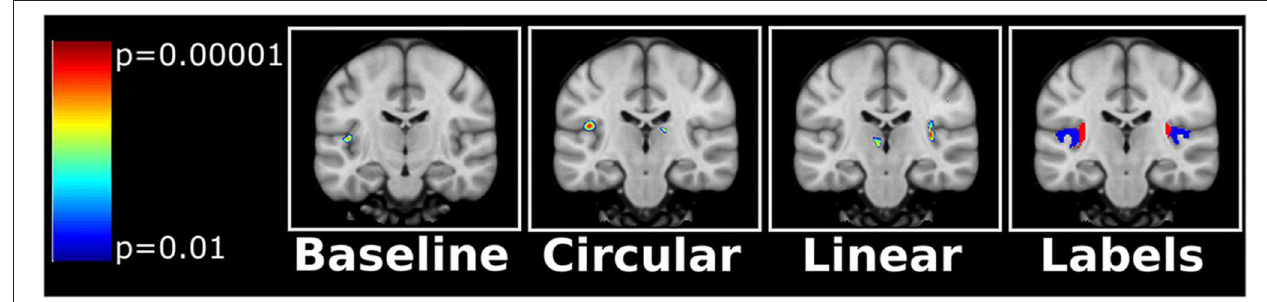
FIGURE 2 | Uncorrected t-maps from the SPM analyses. Decreased 18 F-FDG uptake was evident in Heschl’s gyrus in the patients with Menière’s disease compared to the healthy control group. During linear vestibular stimulation the Menière’s patient displayed a decreased 18 F-FDG uptake in the right Heschl’s gyrus and a cluster in the left thalamus. However, during angular stimulation (circular) the Menière’s patient displayed a decreased 18 F-FDG uptake in the left Heschl’s gyrus/intersection to the parietal operculum. The anatomical regions as defined in the SPM atlas are shown on the right (blue label = Heschl’s gyrus, red label = posterior insula). Orientation by neurological convention: Left side of image is left side of